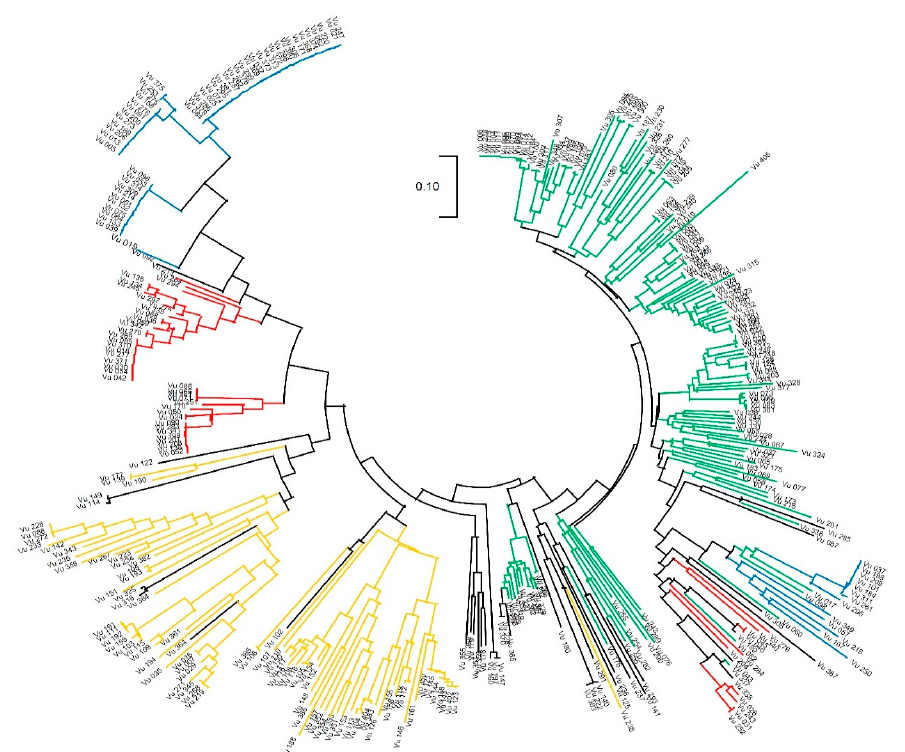
Figure 3. Neighbor-joining tree of the 376 global cowpea accessions using MEGA X, and the varieties in each colored branch are represented based on the structure population (Q1, green; Q2, blue; Q3, yellow; Q4, red; admixture, black).